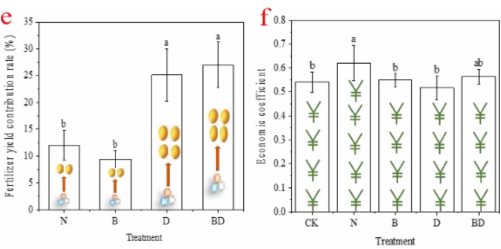
Figure 6. Effects of biochar and inhibitor addition on yield, biomass, and economic indicators. ( a ) The soybean yield; ( b ) Hundred-grain weight of soybean; ( c ) Air-dried straw weight; ( d ) Above-ground biomass; ( e ) Fertilizer yield contribution rate; ( f ) Economic coefficient. Small letters of a-c in the figure represent the significant difference among treatments at the maturation stage ( n = 5, p < 0.05).